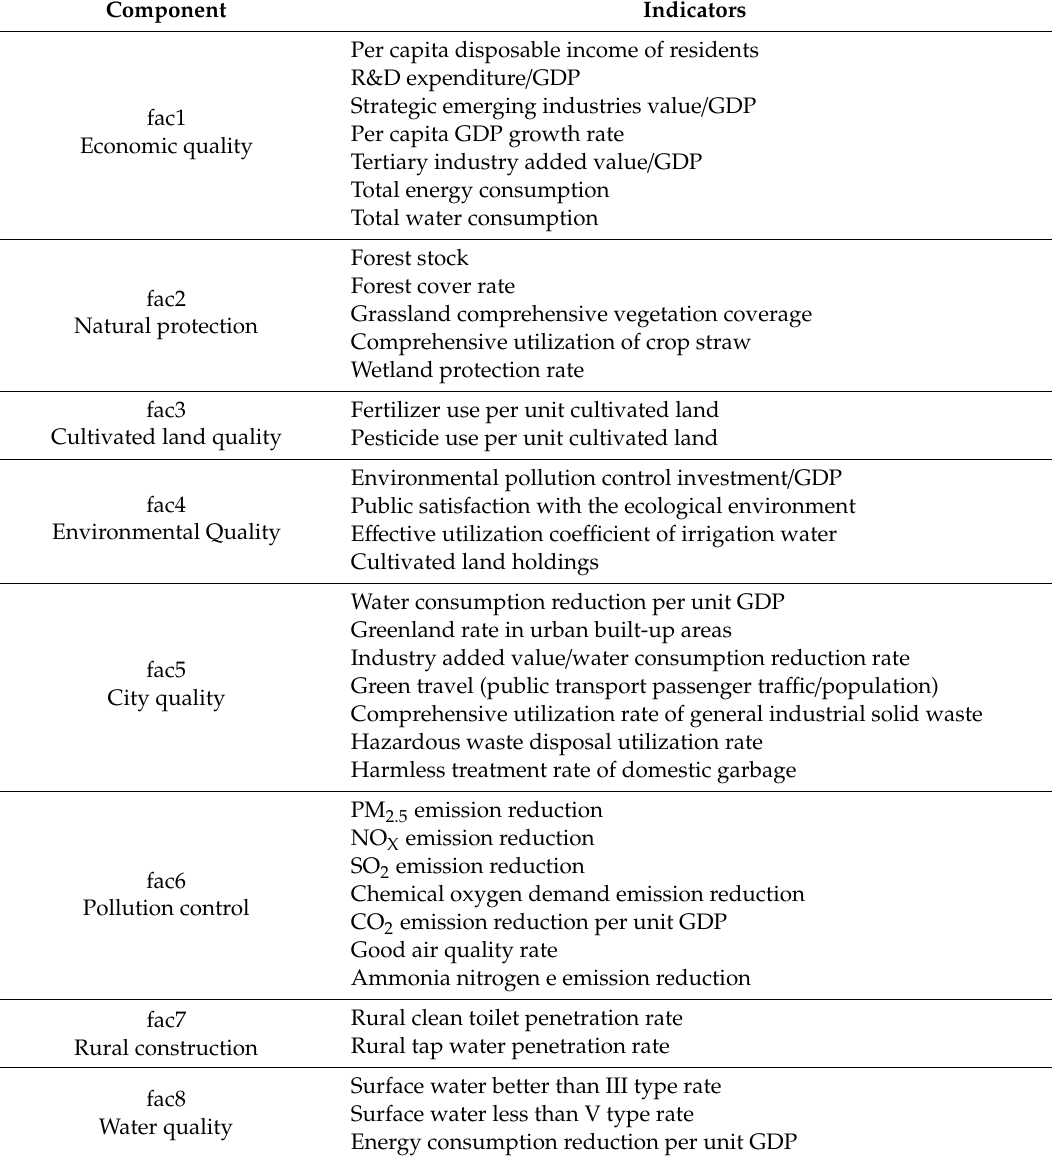
Table 4. Components and indexes for the ecological civilization